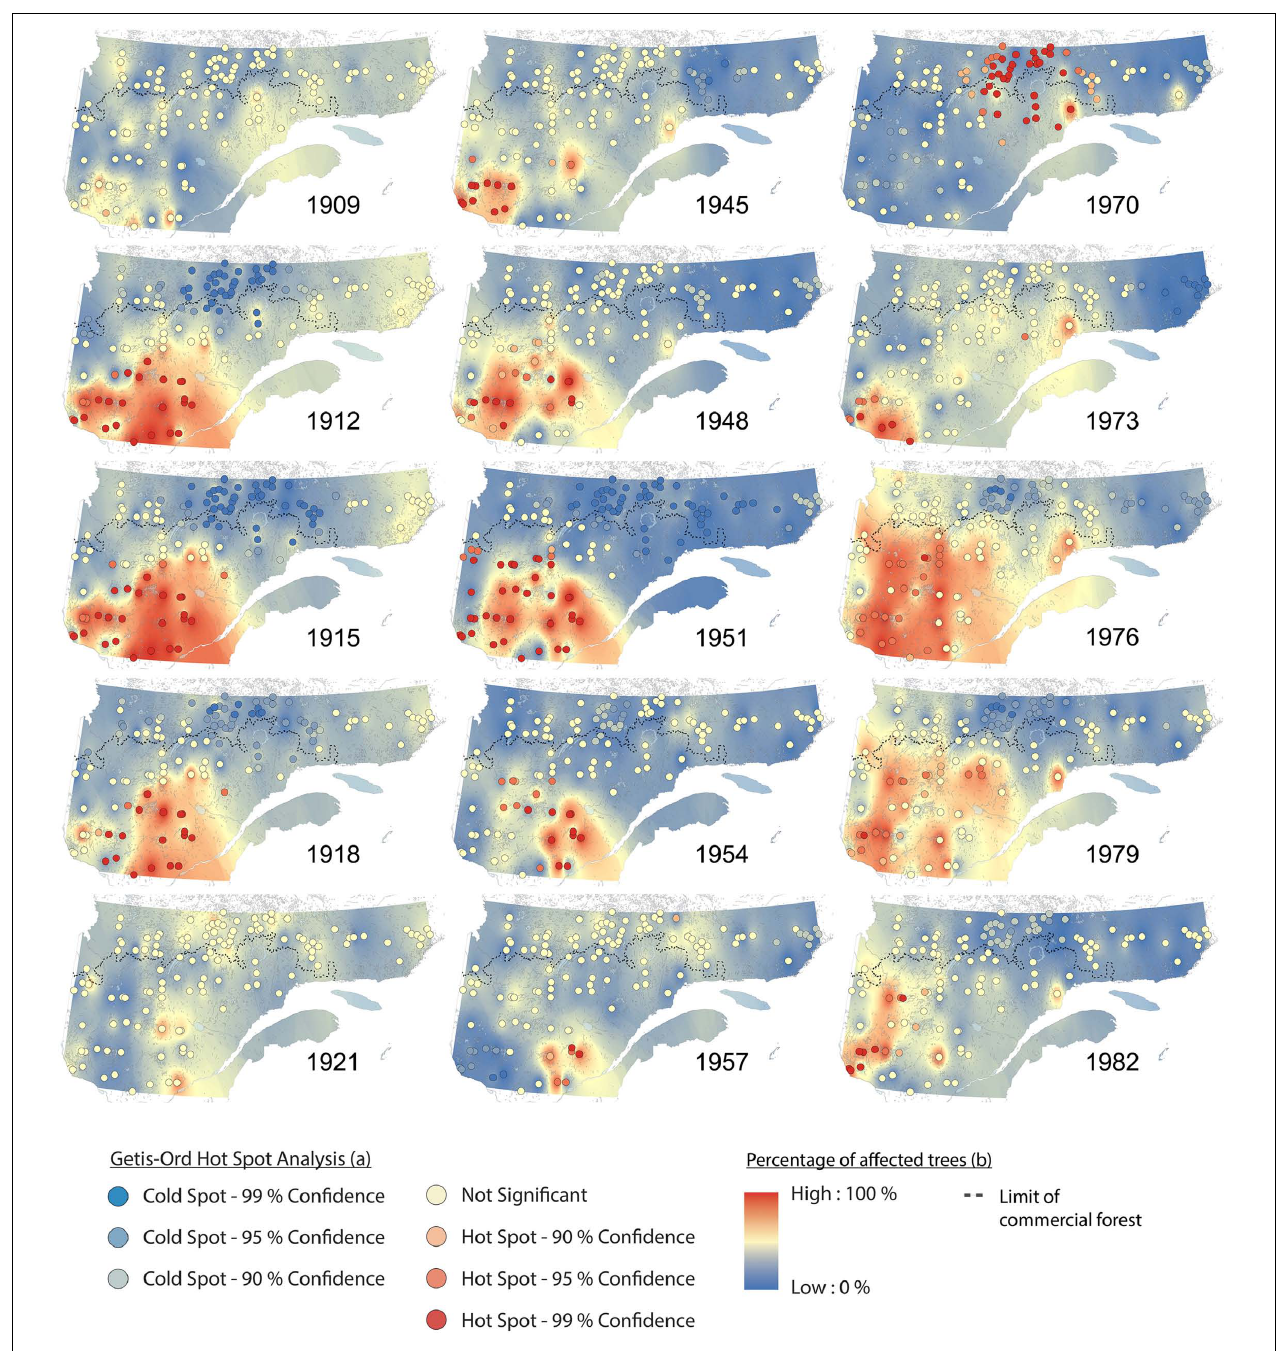
FIGURE 4 | Spatiotemporal patterns of spruce budworm impacts (percentage of affected trees) and synchrony (Getis-Ord hotspot analysis) in eastern Canadian boreal forests for the three most important outbreaks over the 20th century.